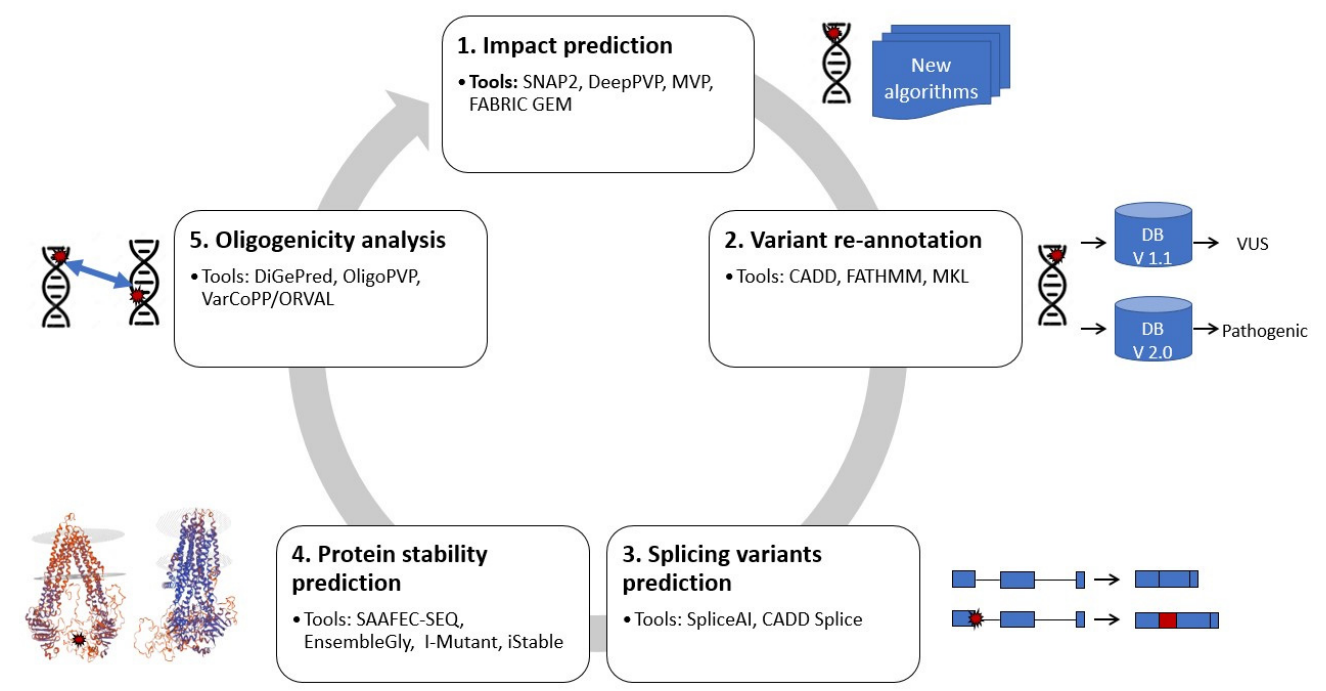
Figure 1. Overview of the machine learning strategies for WES reanalysis from the single variant analysis to more complex genomics event (gene–gene interactions). 1. Predicting the impact of sequence alterations/mutations. This strategy consists of predicting the effect of a sequence change on protein. 2. Variant re-annotation strategies try to re-annotate the variants after availability of new information/discoveries. 3. Variants that alter splice isoform frequencies are predicted using methods in this strategy. 4. In this category, protein folding/protein structural differences are assessed. 5. Oligogenic analysis is a strategy for analysis of digenic (gene pairs) and oligogenic diseases. Examples of tools for reanalysis of rare diseases using machine learning are presented for each strategy.